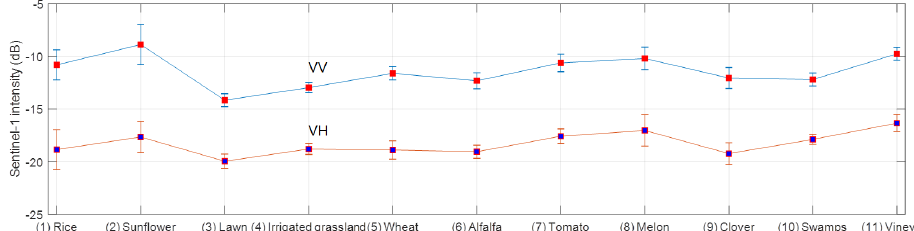
Figure 3. The average and standard deviation of the eleven different classes for VV and VH